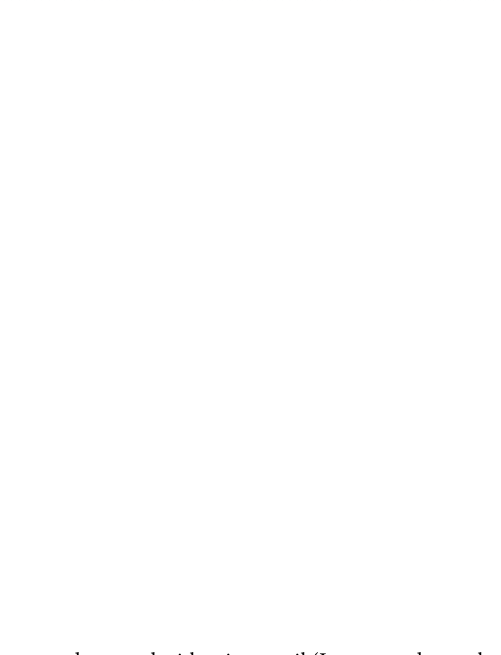
Table 6. Physico-chemical characteristics of extracted oil through hydrodistillation. SD standard deviation. *Values given are mean of three replicates.